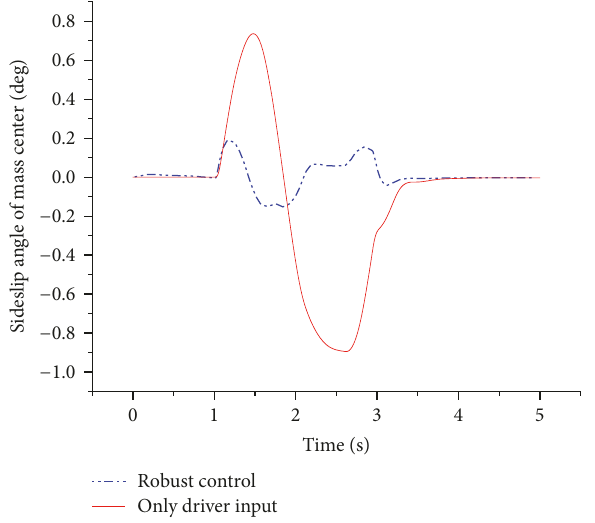
Figure 14: Active front steering correction angle.